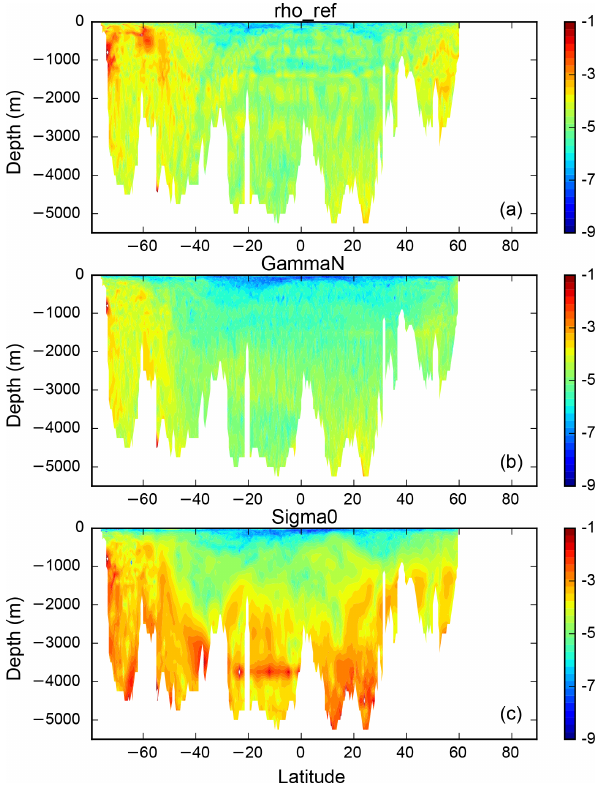
Figure 5. Decimal logarithm of the sine between the neutral vec- tor, and the gradient of ρ ref (a) , γ n (b) and σ 0 (c) as a function of latitude and depth at 30 ◦ W (in the